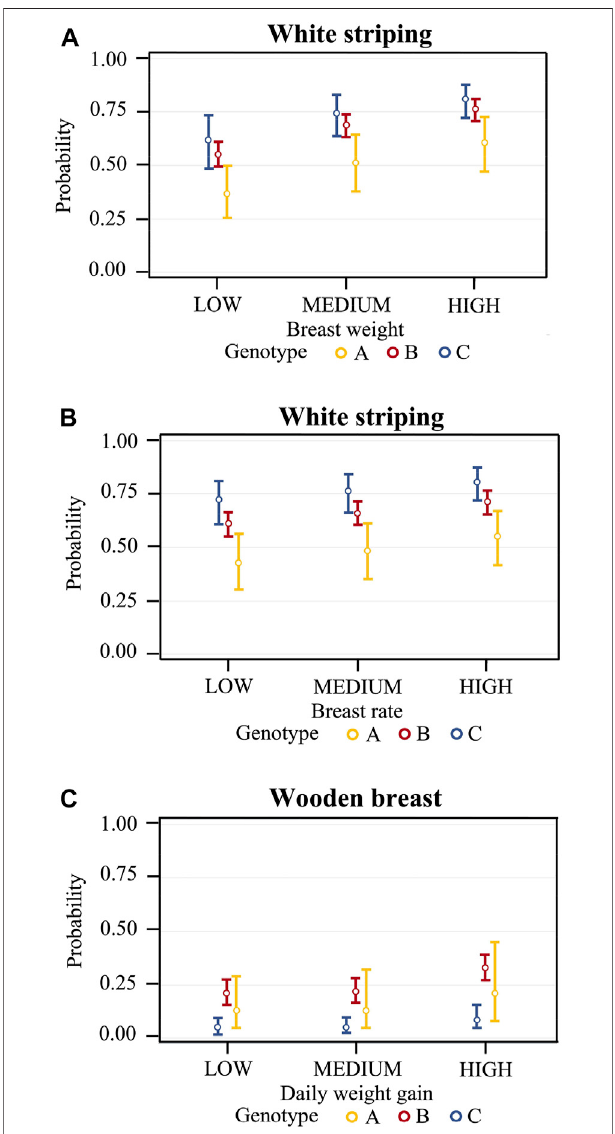
FIGURE 1 | Predicted probabilities of WS occurrence for breast weight class (LOW < 850 g, MEDIUM 850 – 960 g, HIGH > 960 g) in male and female broiler chickens (A) ; predicted probabilities of WS occurrence for breast yield class LOW < 39.0%, MEDIUM 39.0 – 40.7%, HIGH > 40.7%) (B) ; predicted probabilities of WB occurrence for daily weight gain class LOW < 70.7 g/d, MEDIUM 70.7 – 78.0 g/d, HIGH > 78.0 g/d) (C) . Predicted probabilities are given separately for the different genotypes (genotype A: Ross 708; genotype B: Ross 308; genotype C: Cobb 500) used in the experimental trials at the University of